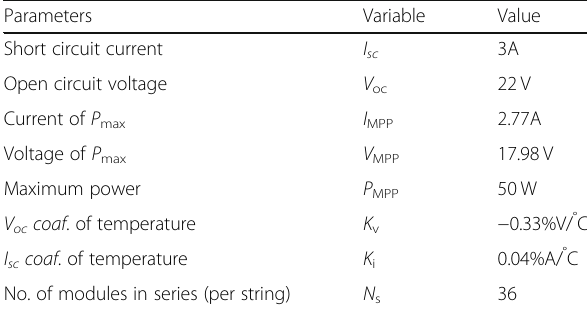
Table 1 Parameters of the EGing-50 W Model